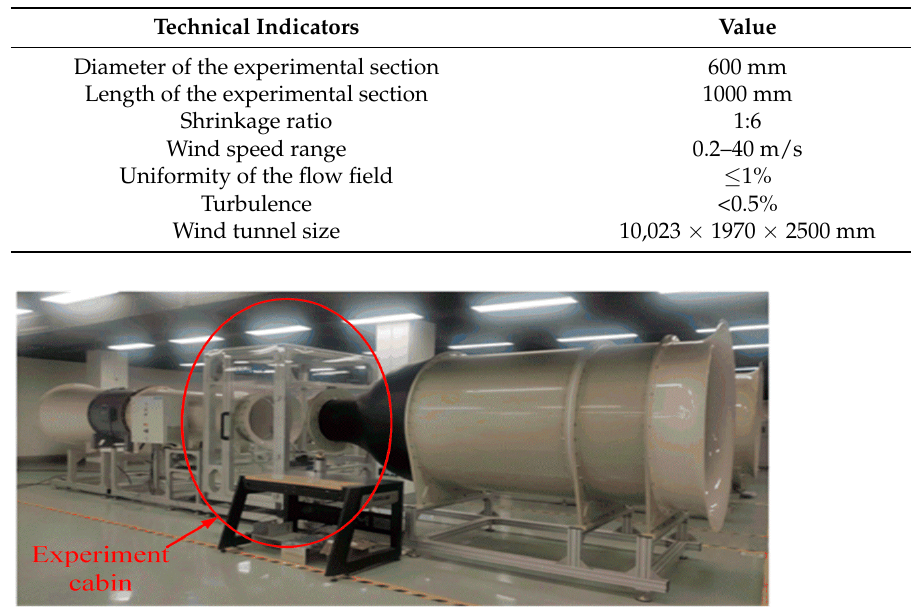
Figure 2. Picture of hemispherical seven-hole probe. ( a ) Schematic diagram of the probe structure, and ( b ) Photograph of the probe.